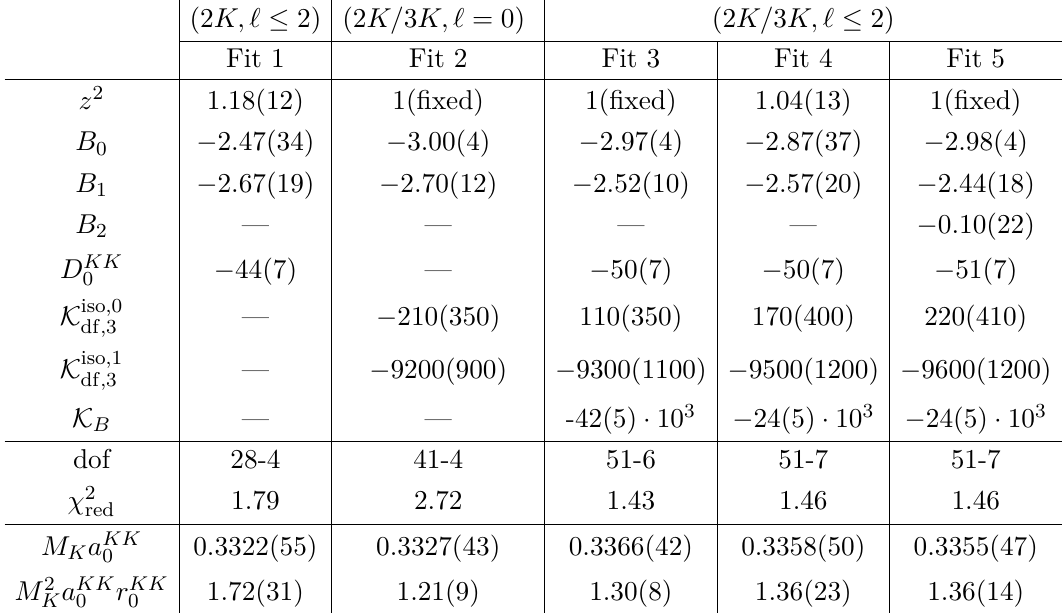
Table 10. Fit results for kaons on the N200 ensemble using M K L = 7 . 225143 , with notation as in table 9. Each fit contains all 2 K + energy levels (in the appropriate irreps) below E ∗ and all 3 K + levels (in the appropriate irreps) below E ∗